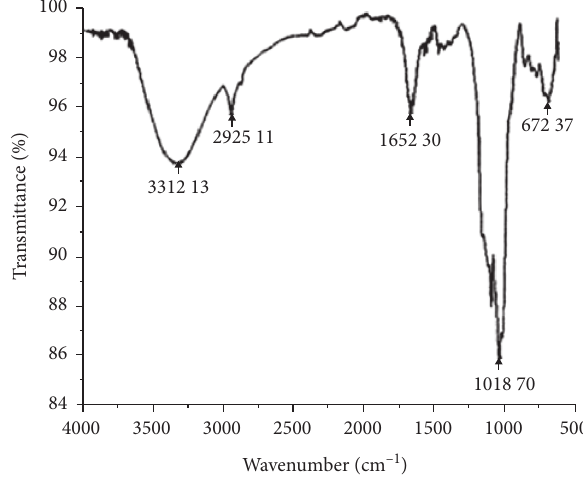
Figure 4: FTIR analysis provides specific information about chemical structure of the bioemulsifier produced by Steno- trophomonas maltophilia